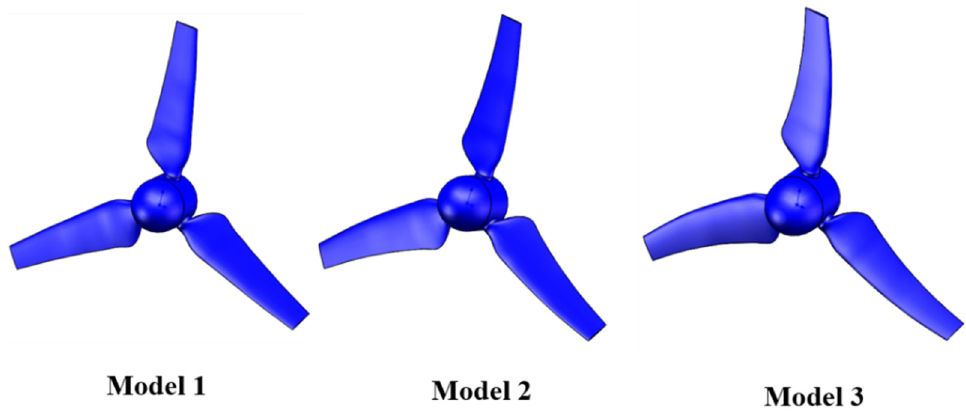
Figure 6. Different swept blades 3D model.